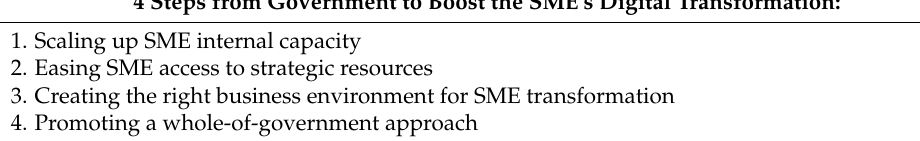
Table 5. Government boost for